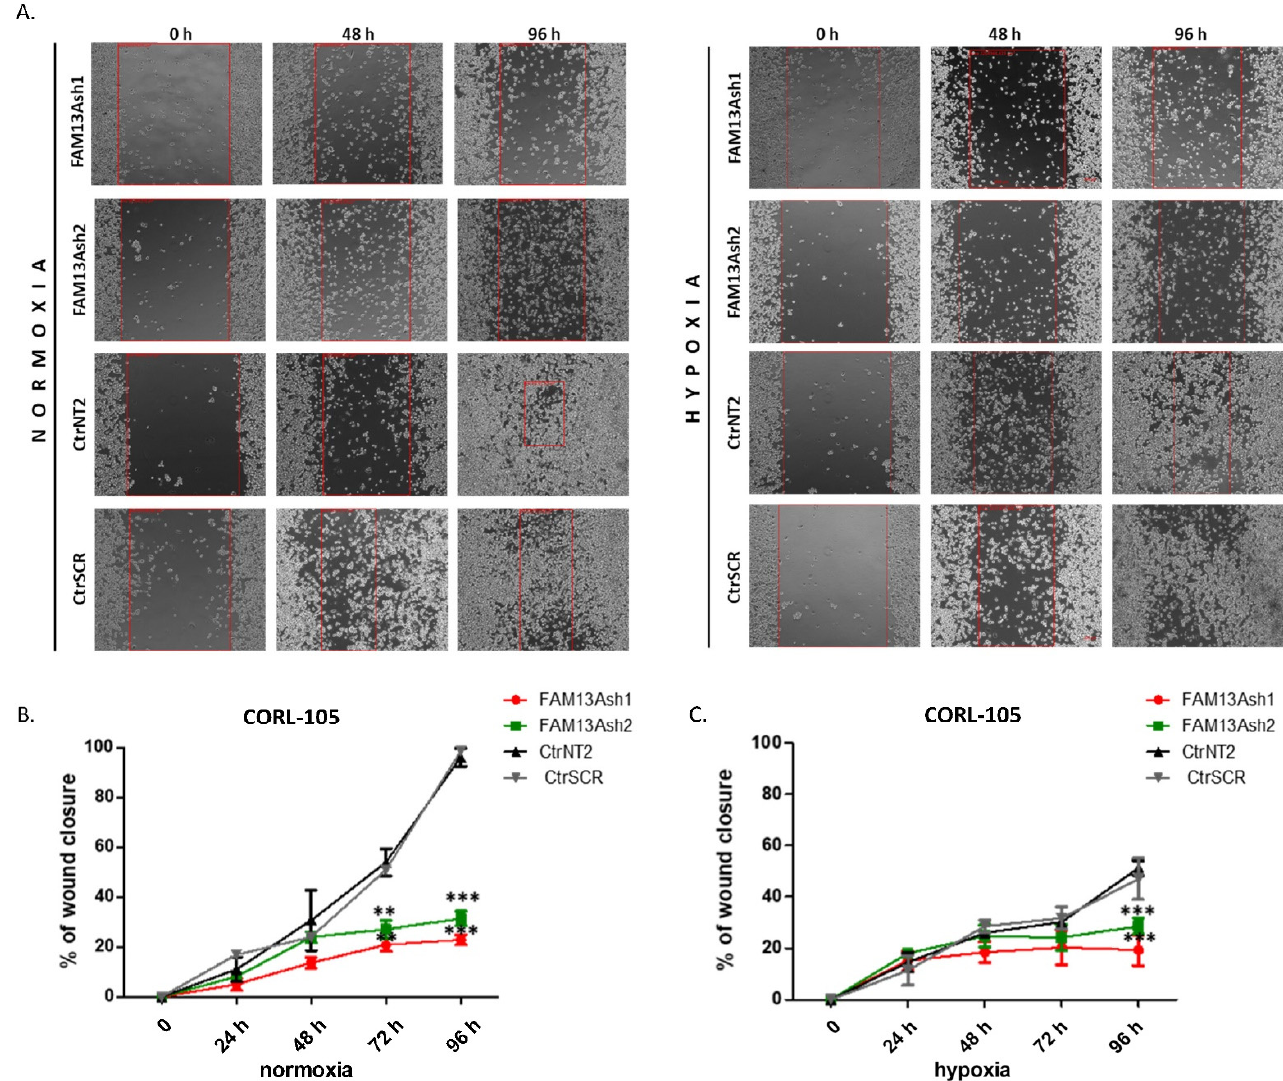
Figure 4. Knockdown of FAM13A suppresses CORL-105 lung cancer cell migration. The migration of A549 cells with FAM13A knockdown and controls was monitored for 96 h under normoxia and hypoxia conditions. The inserts were used to generate a defined gap for measuring the migratory rates. Cell suspension in low serum media was added to the open end at the top of the insert. The cells were incubated overnight to form the monolayer. After 24 h inserts were removed from wells. The wound healing closure was visualized under a light microscope, images were taken in 24 h intervals. ( A ) Representative microscopy images of the wound-healing assay (magnification, ×10). Images of FAM13A depleted cells (FAM13A sh2RNA) and control (Ctr sh1RNA NT2) cells, cultured under normoxia ( left panel) and hypoxia ( right panel), were taken at the time 0 h, 48 h and 96 h of wounding. ( B , C ) Wound confluence (% of wound closure) was measured at 5 time points (0 h, 24 h, 48 h, 72 h, 96 h) after wound generation for FAM13A knockdown CORL-105 cells: FAM13A sh1RNA (red), FAM13A sh2RNA (green) and controls: Ctr shRNA NT2 (black), Ctr shRNA SCR (grey) cultured in normal oxygen concentration ( B ) and under hypoxia ( C ). Data is expressed as the mean ± SEM of n = 3 exp. A two-way ANOVA with Bonferroni posttest was used for statistical analysis. p values ≤ 0.05 indicate a significant difference, as marked by an asterisk (** p < 0.01, *** p < 0.001). The experiments were performed in triplicate and repeated three times.